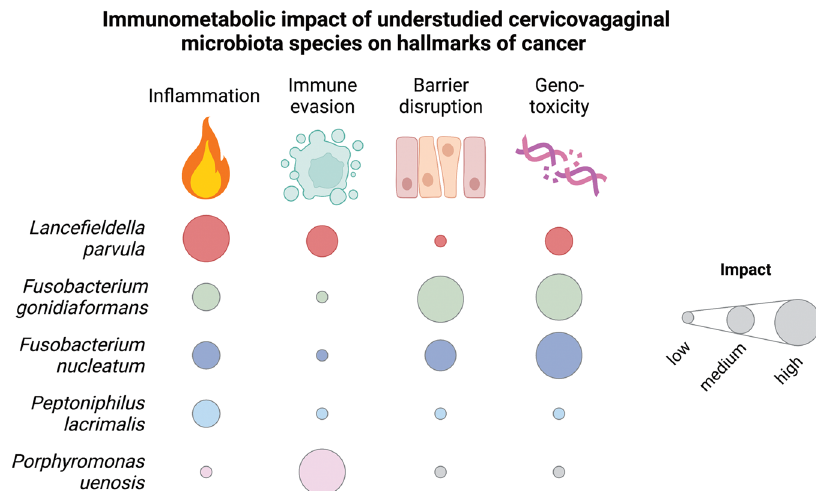
Fig. 9 Summary of hallmarks of cancer in fl uenced by BVAB associated with cancer. Heatmap depicts the relative impact that each bacterial species contributes to the putative pro-tumorigenic microenvironment based on our 3-D cervical cell model. Heatmap colors were assigned based on standardized levels of signi fi cantly ( p < 0.05) modulated immunoproteomic and metabolomic biomarkers related to the hallmarks of cancer such as in fl ammation, avoiding immune destruction, barrier disruption, and genomic